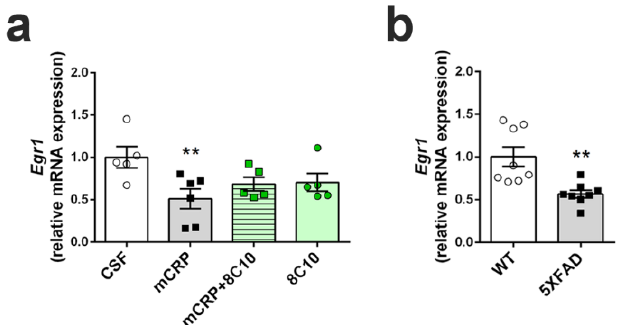
Figure 7. Decreased expression of the neural plasticity marker Egr1 induced by mCRP was partially prevented by 8C10 antibody. RNA extracts of the whole hippocampus tissue showed reduced levels of expression of the Egr1 gene after 6 months of mCRP treatment, but 8C10 showed a trend to palliate this decline ( a ). Egr1 expression was decreased in the hippocampus of 5XFAD mice to a level similar to mCRP-injected mice ( b ). Expression of Egr1 was normalized to the corresponding expression of Tbp gene. Values are mean ± SEM (( a ) CSF N = 5, mCRP N = 6, mCRP + 8C10 N = 5 and 8C10 N = 5, and ( b ) WT N = 8 and 5XFAD N = 8). Statistics: ** p < 0.01 compared to Control group.